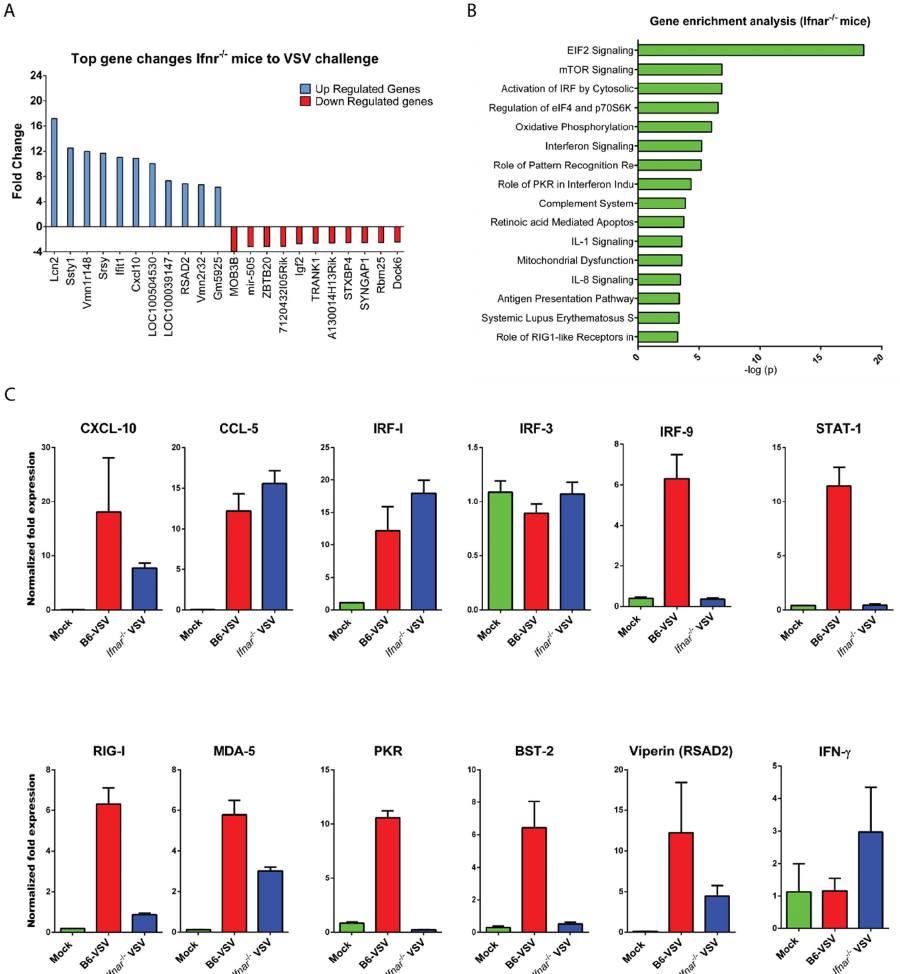
Figure 5. VSV infection in the brain induces type I IFN signaling-independent innate immune pathways. Microarray analysis was performed on the total RNA extracted from the mice brains at day three post-infection along with mock-infected control. ( A ) A representative bar graph showing the top 10 candidates di ff erentially (upregulated in blue and downregulated gene in red). ( B ) Ingenuity pathway analysis tool was used to find the top biological pathway in the VSV-infected mice brains and are represented in the bar graph. The negative log p values are plotted on the graph X -axis. ( C ) A few selected genes were subjected to qRT-PCR analysis to validate the temporal change in the expression observed in microarray analysis, e.g., CXCL10, CCL-5 IRFs, BST-2, Viperin, etc. The fold change in these genes was calculated by normalizing the data with housekeeping gene ( β -actin) as an internal control from the same sample using ∆∆ Ct